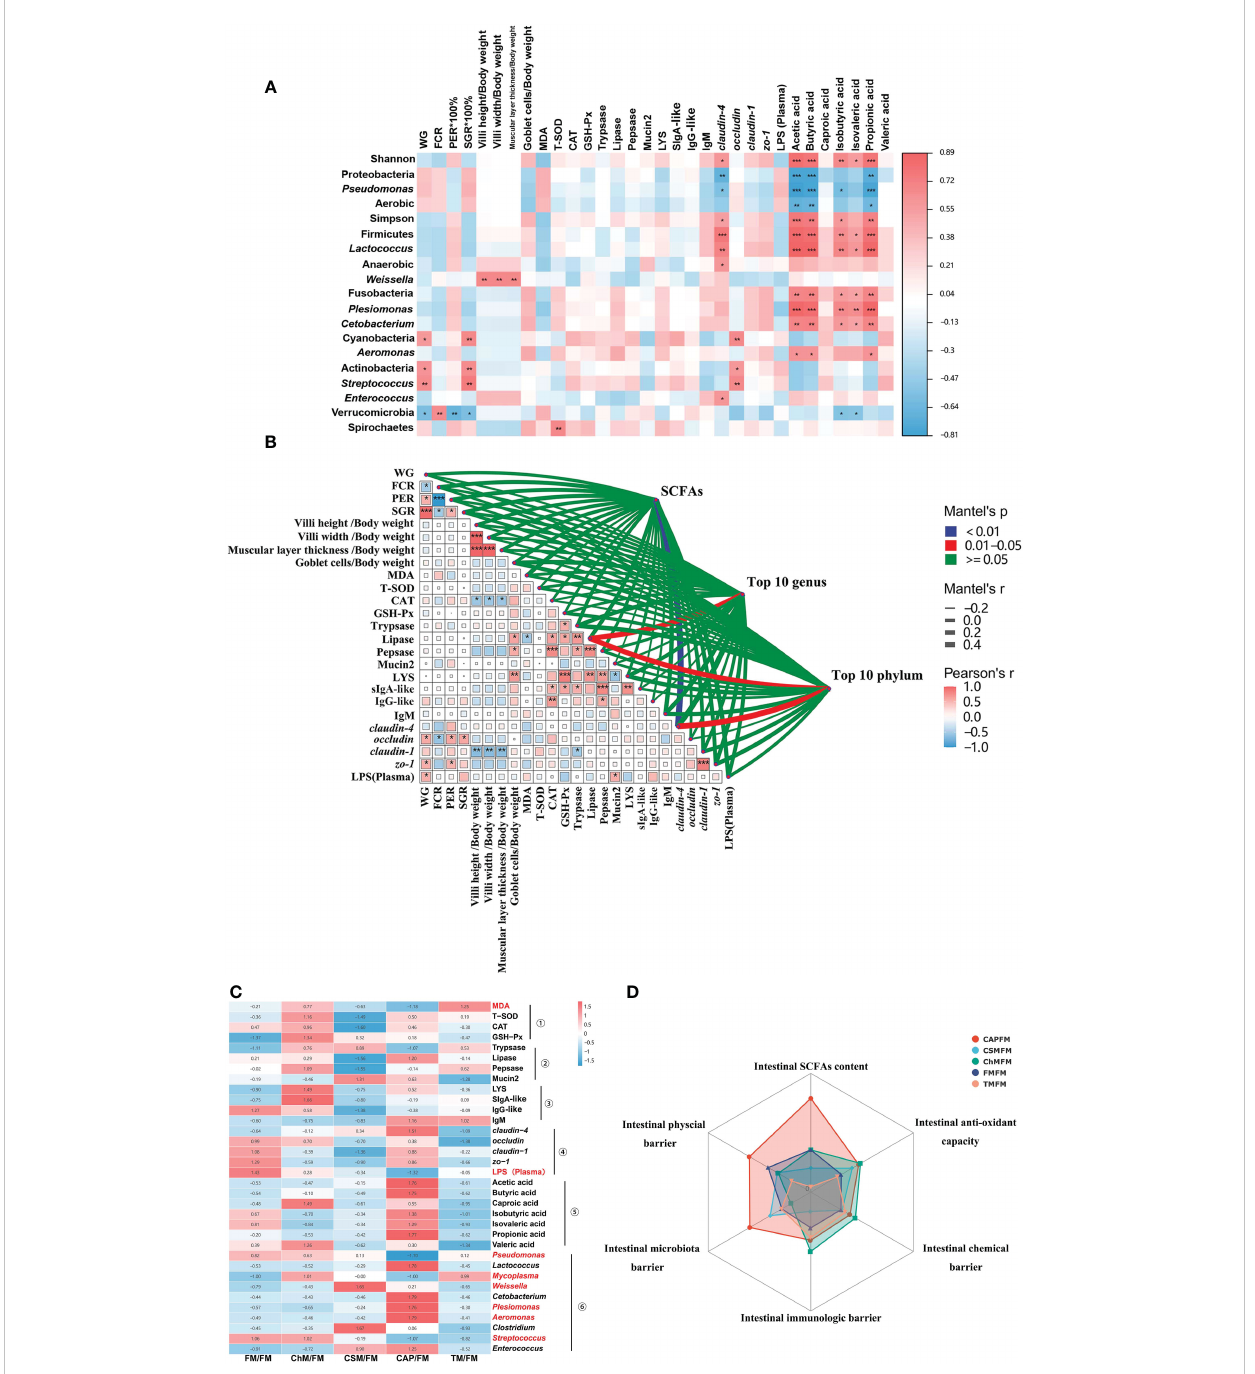
FIGURE 8 Combined analysis and scoring of all data obtained from various protein treatments: (A) Heat map of Pearson ’ s correlation analysis (|r|>0.6, P 0.05) of bacterial phenotype, abundance at the genus/phylum level, SCFAs, and physiological biomarkers. On the heat map, the red square indicates a positive association, while the blue square indicates a negative correlation. (B) The Mantel test was performed on the core microbiota, intestinal SCFAs, and physiological indicators. The size of the square in the matrix symbolizes the coef fi cient value, with red squares representing positive correlations and blue squares negative correlations. The lines outside of the matrix reveal the relationship between the core microbiota as well as intestinal SCFAs and physiological markers, with thicker lines indicating stronger associations. (C) Heat map of the z-score analysis was clustered as the intestinal antioxidant ① , intestinal chemical barrier ② , intestinal immunological barrier ③ , intestinal physical barrier ④ , intestinal SCFAs contents ⑤ , and intestinal microbiota barrier ⑥ . The red-highlighted indexes indicated their negative relationship with fi sh intestinal health, whereas the black- highlighted indicated their positive relationship with fi sh intestinal health. (D) On the basis of the Z-score calculated from panel (C) , a multidimensional radar map analysis of the effects of fi ve protein treatments on the intestinal health of juvenile largemouth bass was presented. The statistical differences were presented as * P<0.05 ,** P<0.01 , and *** P<0.001.